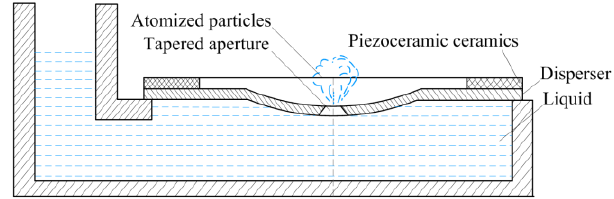
Figure 1. Illustration of the principle of atomization.